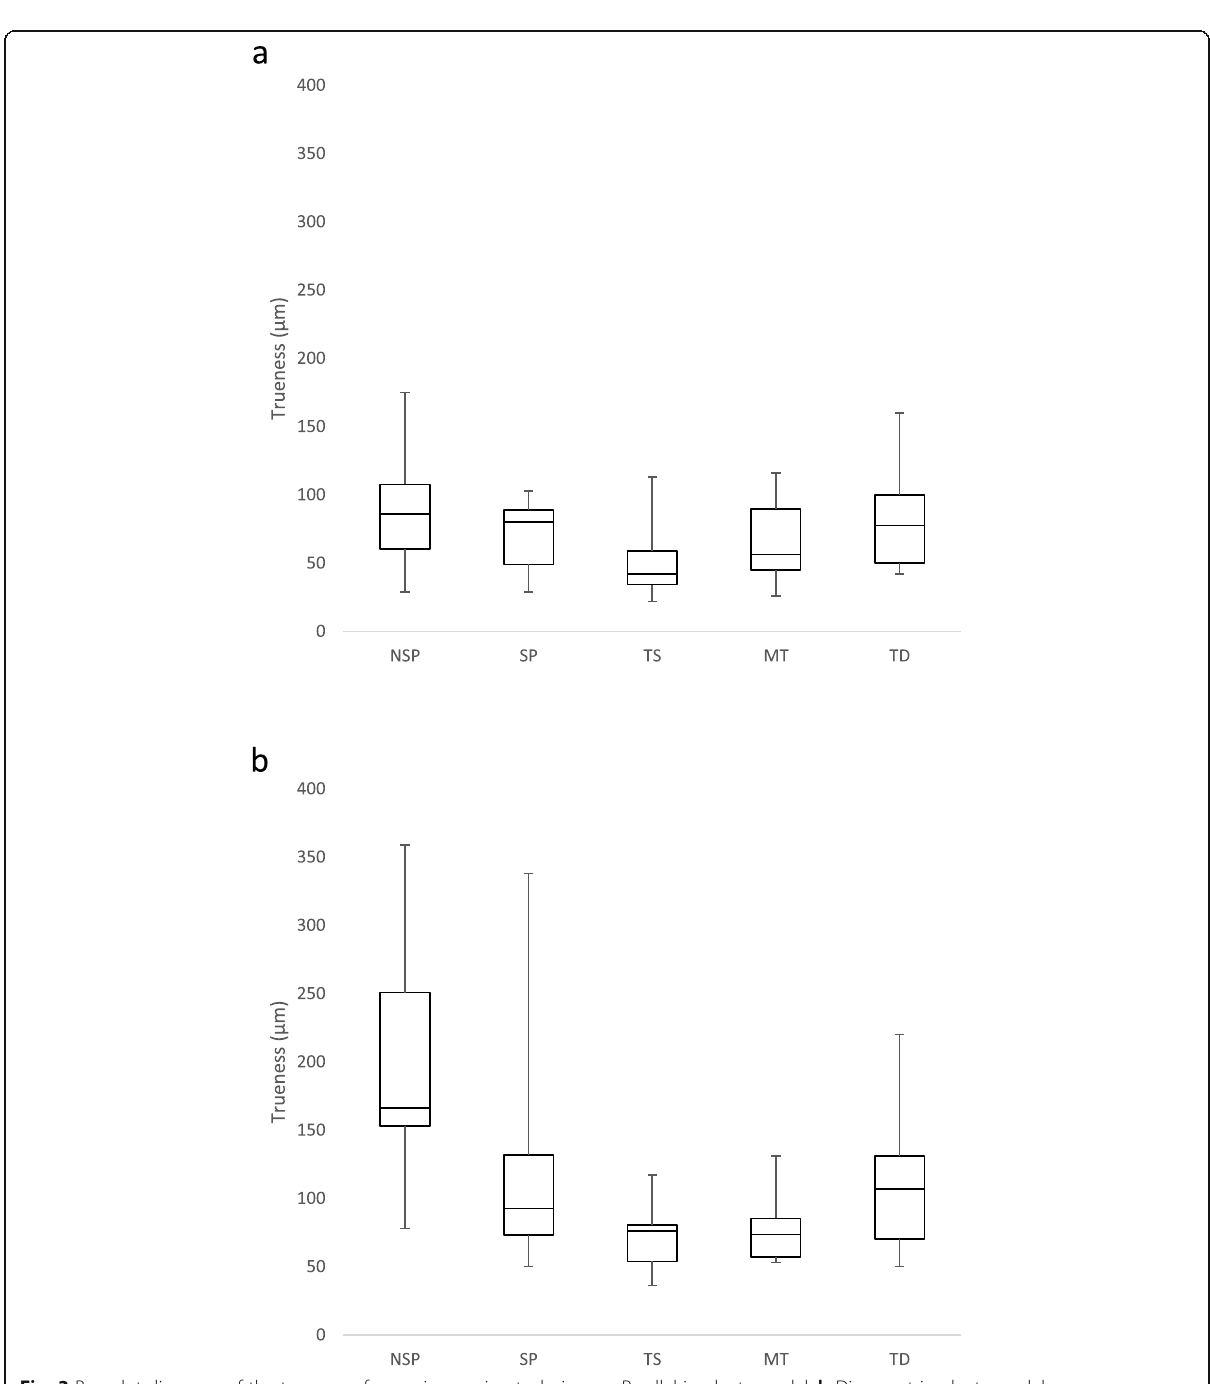
Fig. 3 Box plot diagrams of the trueness of every impression technique. a Parallel implants model. b Divergent implants